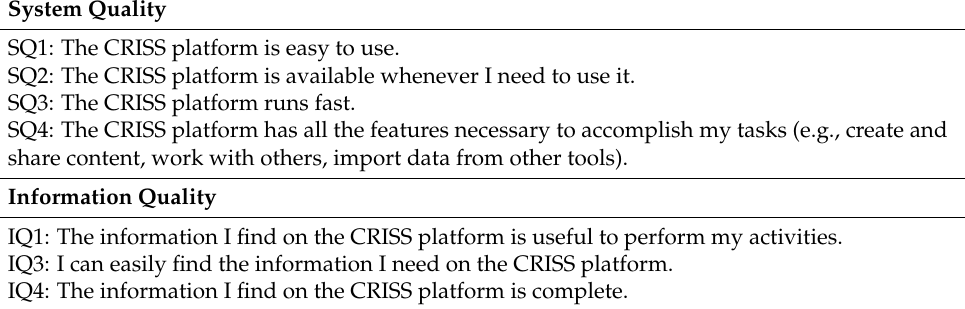
Table A1. Final CRISS success